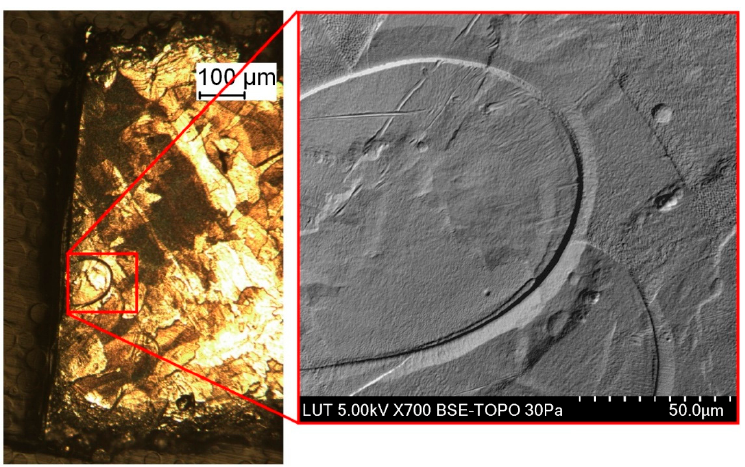
Figure 10. Magnified images of the samples showing the microstructure. ( a ) Cold-rolled steel sheet, ( b ) PBF produced sheet. Areas of interest circled in red.